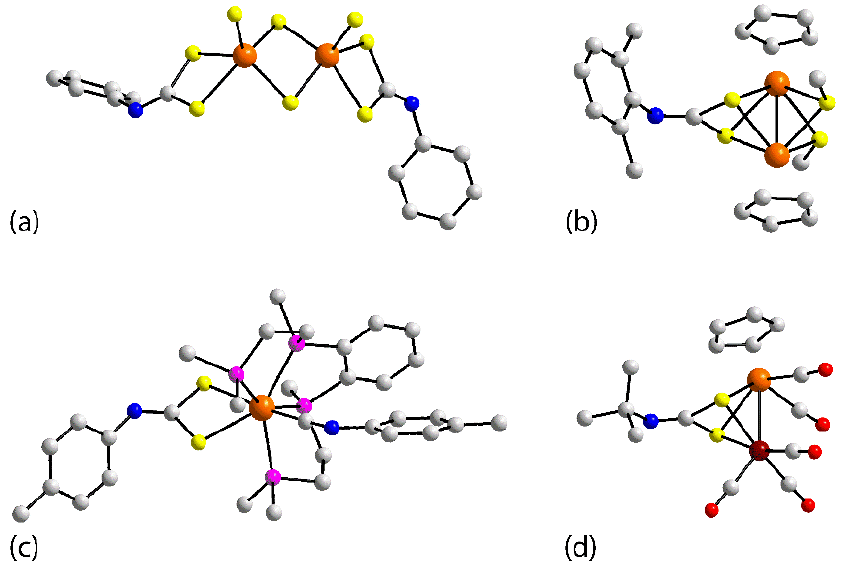
Figure 2. Molecular structures of ( a ) the {Mo(=S)(µ 2 -S)[S 2 C=N(Ph)]} 22 − di-anion in 1 , ( b ) [CpMo(SMe)] 2 [S 2 C=N(2,6-Me 2 C 6 H 3 )] ( 2 ), ( c ) (Ph 2 P(CH 2 ) 2 P(Ph)C 6 H 4 P(Ph)(CH 2 ) 2 PPh 2 )W(C≡NC 6 H 4 Me-4)[S 2 C=N(4-tolyl)] in 3 , and ( d ) [CpMo(CO) 2 Mn(CO) 3 ][S 2 C=N(tBu)] ( 5 ). The color code in this and subsequent diagrams is as follows: primary metal center = orange; manganese = brown; sulfur = yellow; phosphorus = pink; oxygen = red; nitrogen = blue; and carbon = gray. Hydrogen atoms are omitted for clarity. In ( c ), only the ipso carbon atoms of the phosphorus-bound phenyl groups are shown.